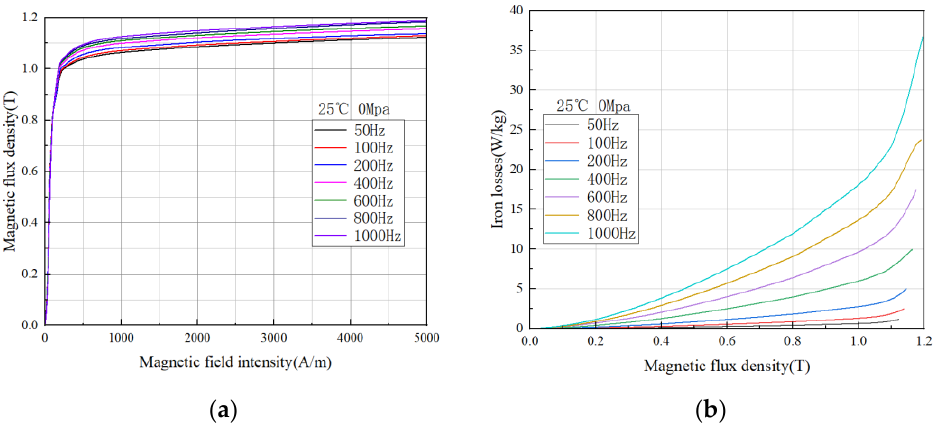
Figure 7. Magnetic properties of grain-oriented silicon steel at different frequencies ( a ) magnetization curves of H-80 material @25 °C and 0 Mpa ( b ) iron loss curves of H-80 material @25 °C and 0 Mpa.